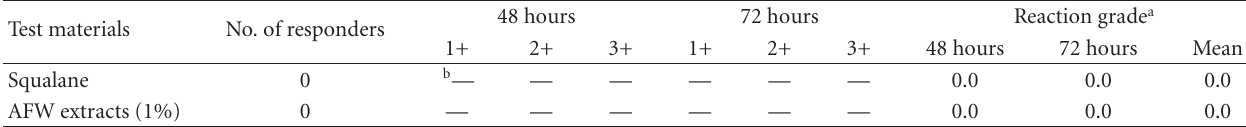
Table 1: Results of human skin primary irritation tests ( n =